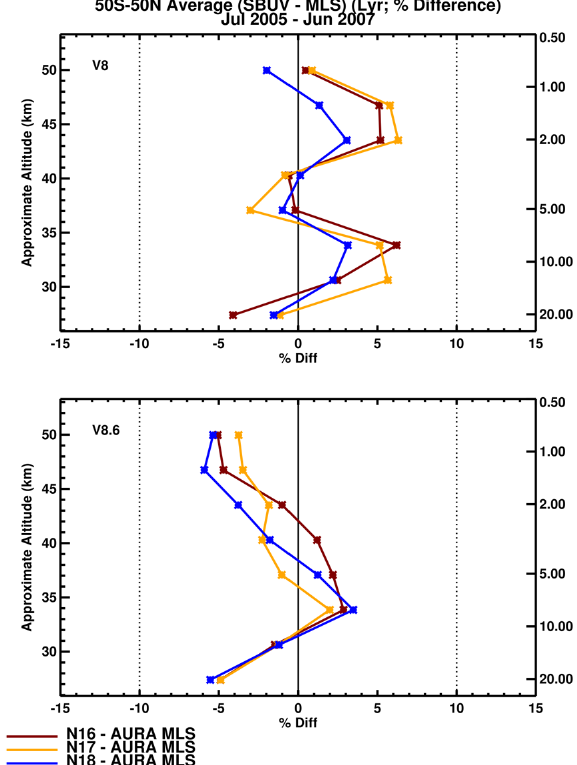
Fig. 12. Profile ozone differences [in percent] between Aura MLS V3.3 data and SBUV/2 instruments on NOAA-16, NOAA-17, and NOAA-18, using zonal averages between 50 ◦ N–50 ◦ S for the pe- riod July 2005–June 2007. Comparisons to the SBUV V8 data prod- uct are shown in the top panel, and comparisons to the SBUV V8.6 product discussed in this paper are shown in the bottom